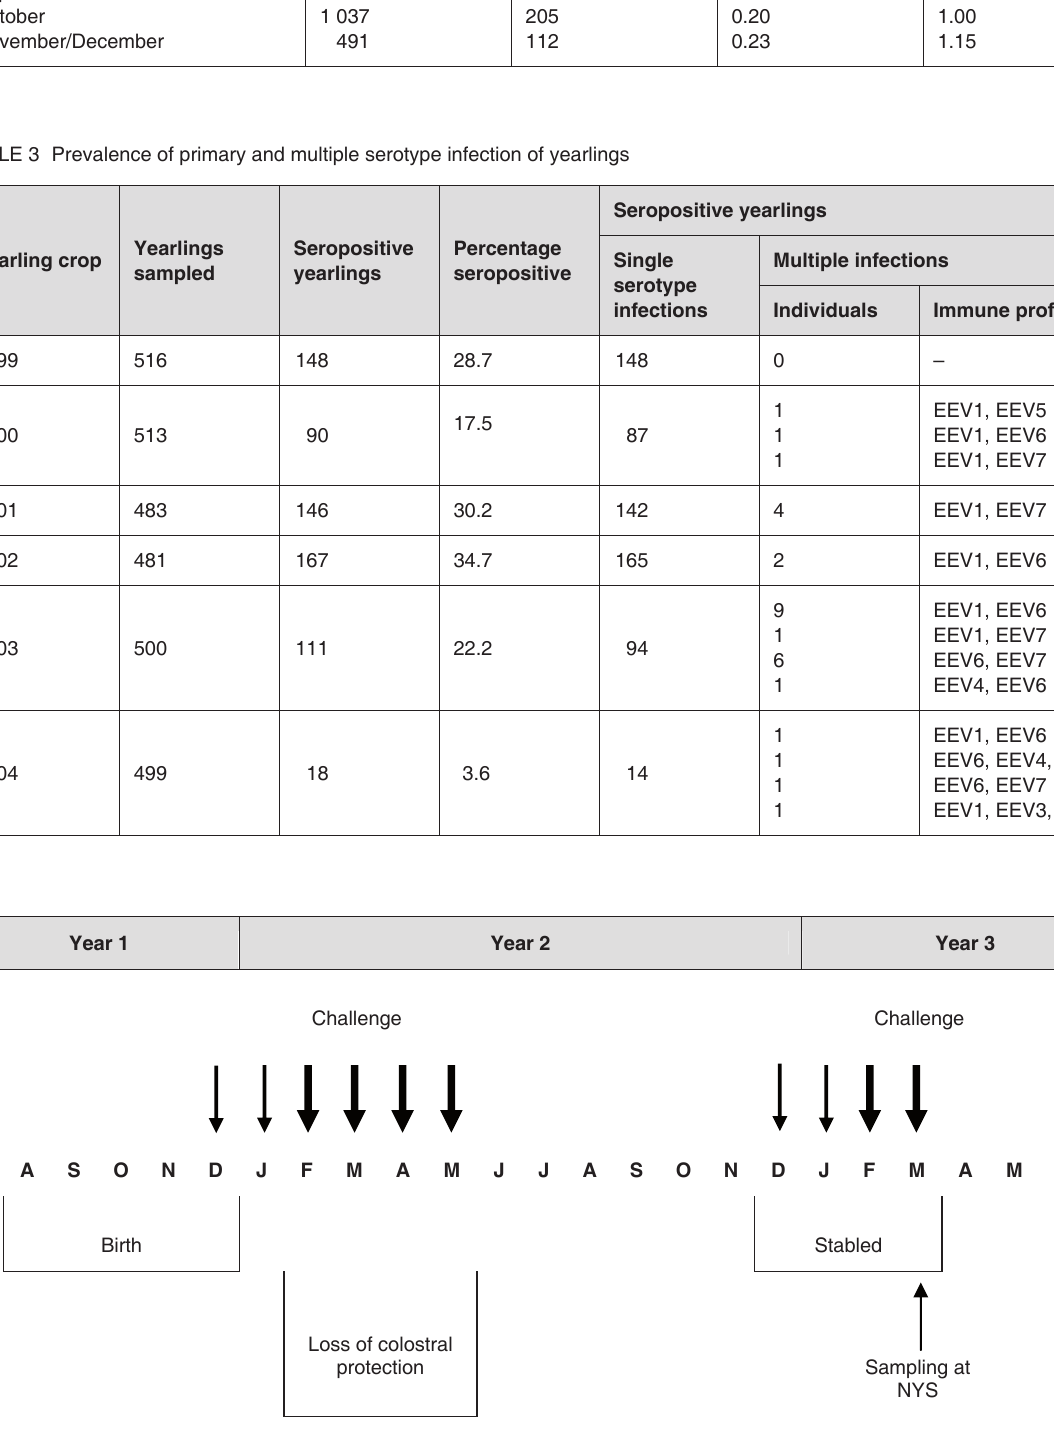
Seasonal exposure of the horse population to the transmission of equine encephalosis virus in South Africa prior to the National Yearling